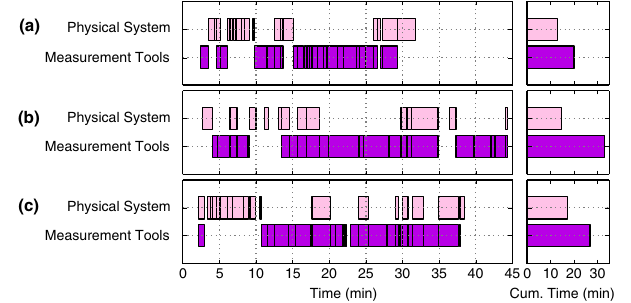
FIG. 5. Comparisons of student activity related to the meas- urement tools vs physical system for three students. Each of the three students spent more time using and modeling the meas- urement tools.